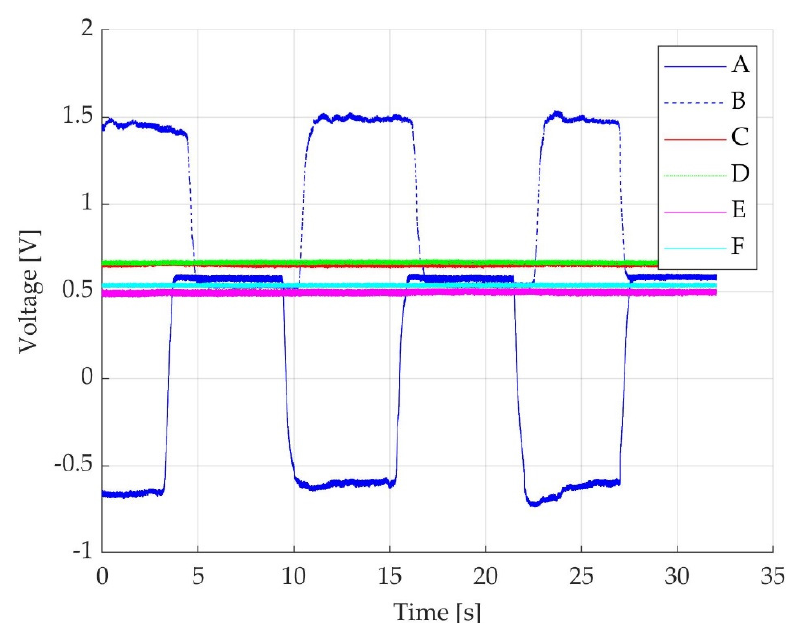
Figure 3. Voltage time-graph representation of six different outcomes: (trace A ) an example of a negative displacement of voltage during three consecutive MVIC, while participant actively dorsiflexs the foot; pedal own mass voltage level, participant’s own limb mass voltage level and belt fixation-derived voltage levels are added to the voltage derived from the participant’s action placed on the pedal; (trace B ) a similar example of a positive displacement of voltage, while participant voluntarily actions on the plate during three consecutive MVIC of active ankle plantarflexion; pedal own mass voltage level, participant’s own limb mass voltage level and belt fixation-derived voltage levels are added to the voltage derived from the participant’ action placed on the pedal; (trace C ) off-set level with pedal own mass, participant’s own limb mass and un-tightened belt, without any voluntary action placed by the participant; (trace D ) off-set level with pedal own mass, participant’s own limb mass without the presence of belt and no voluntary action placed by the participant; (trace E ) off-set level with pedal own mass, participant’s own limb mass with tightened belt just above the knee joint, without any voluntary action placed by the participant; (trace F ) pedal off-set level without the presence of the participant’s foot on the plate.